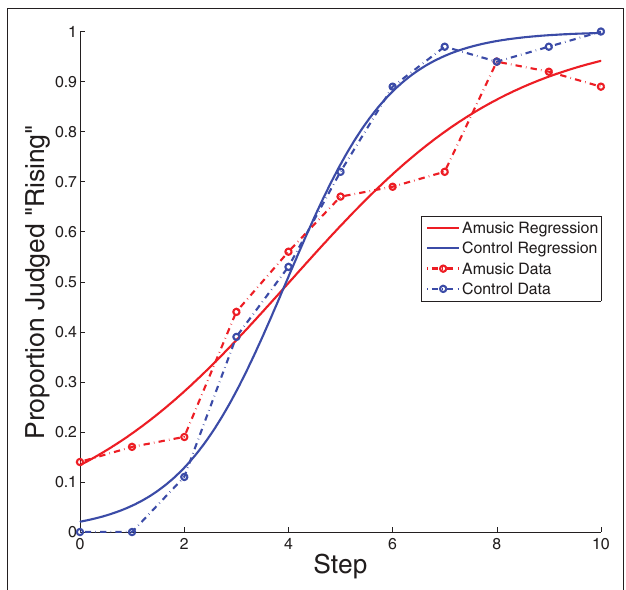
Figure 4 | Observed data and logistic regressions for tone sequence stimuli. These regressions are derived from the summed data across controls and amusics, and represent a regression of the average rather than an average of individual regressions. Binomial confidence intervals are omitted here for clarity, but do not exceed ± 0.17.